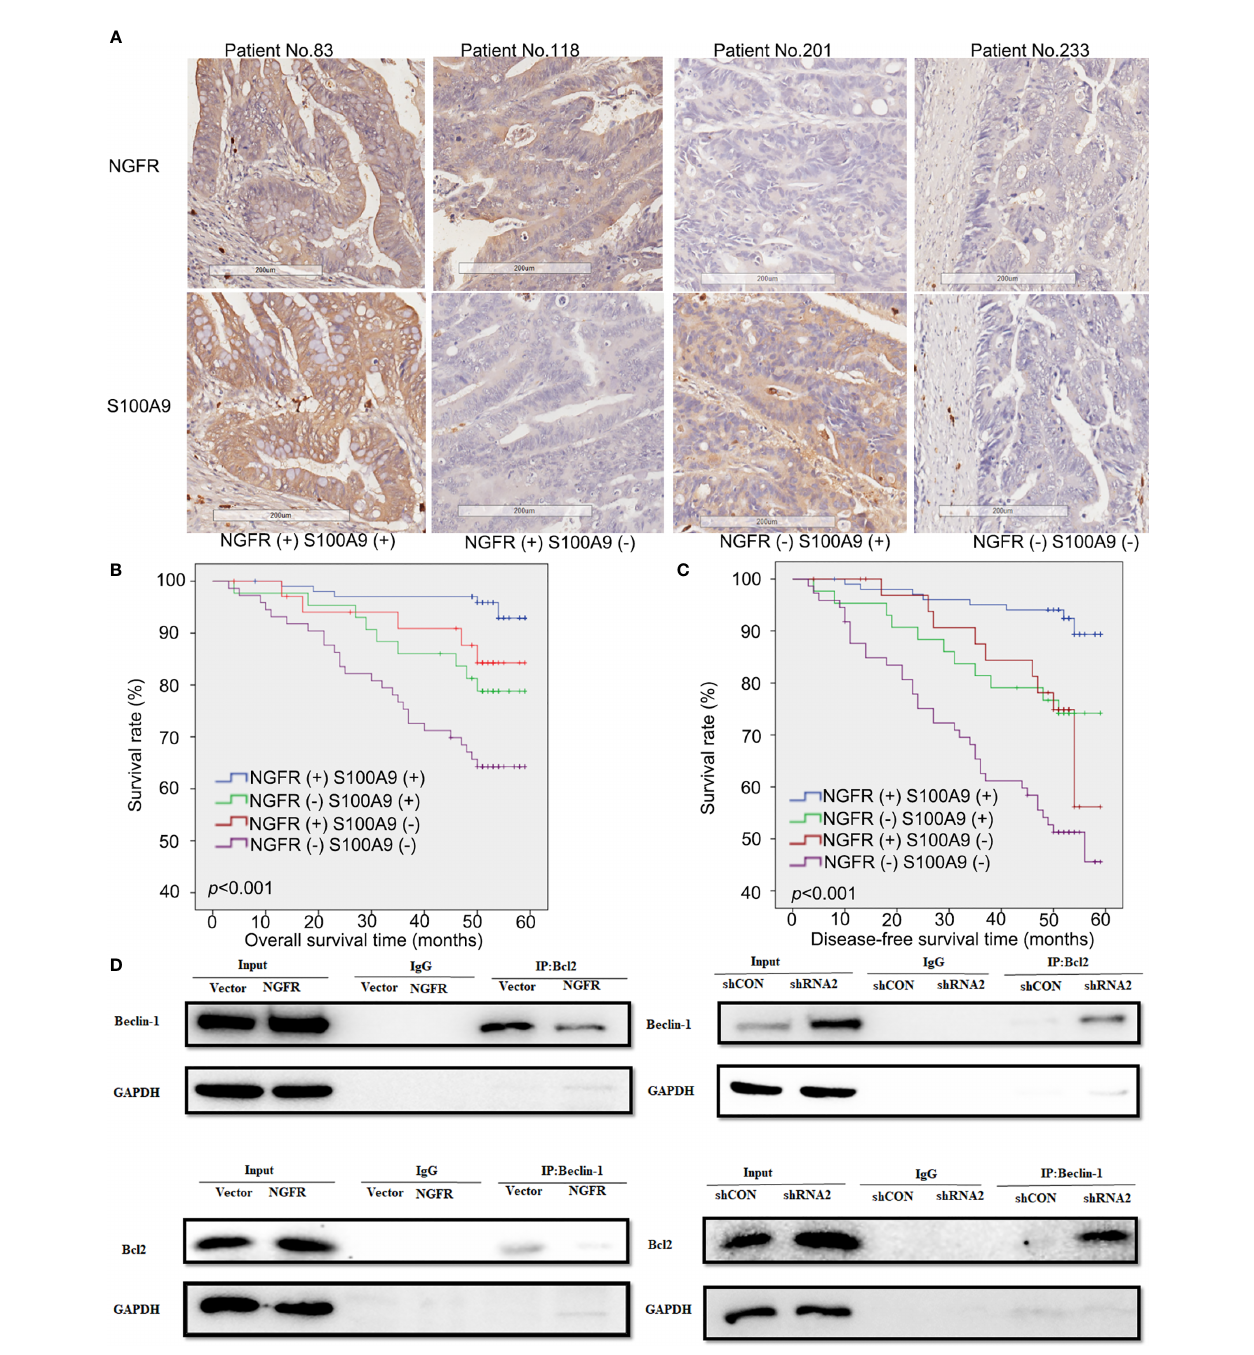
FIGURE 6 | Low expressions of NGFR and S100A9 were associated with poor prognosis in patients with CRC after 5-FU-based chemotherapy. (A) Samples of CRC patients stained by immunohistochemistry. The expressions of NGFR and S100A9 are shown in the cytoplasm (brown stain) of CRC cells. A Kaplan-Meier plot showed that NGFR and S100A9 low co-expression was associated with poor (B) overall survival and (C) disease-free survival in patients with CRC after 5-FU-based chemotherapy. (D) DLD1 and SW480 cells were transfected with an NGFR overexpression plasmid and an shRNA plasmid following a 48-h 5-FU treatment. Cell lysates were then extracted for immunoprecipitation with anti-Beclin-1 or anti-Bcl-2 antibodies, and precipitates were immunoblotted with anti-Bcl-2 or anti-Beclin-1 antibodies. The upper band shows that the combination of Bcl-2 and Beclin-1 was considerably suppressed by overexpressed NGFR. The lower band shows that when NGFR was downregulated, the combination of Bcl-2 and Beclin-1 was markedly